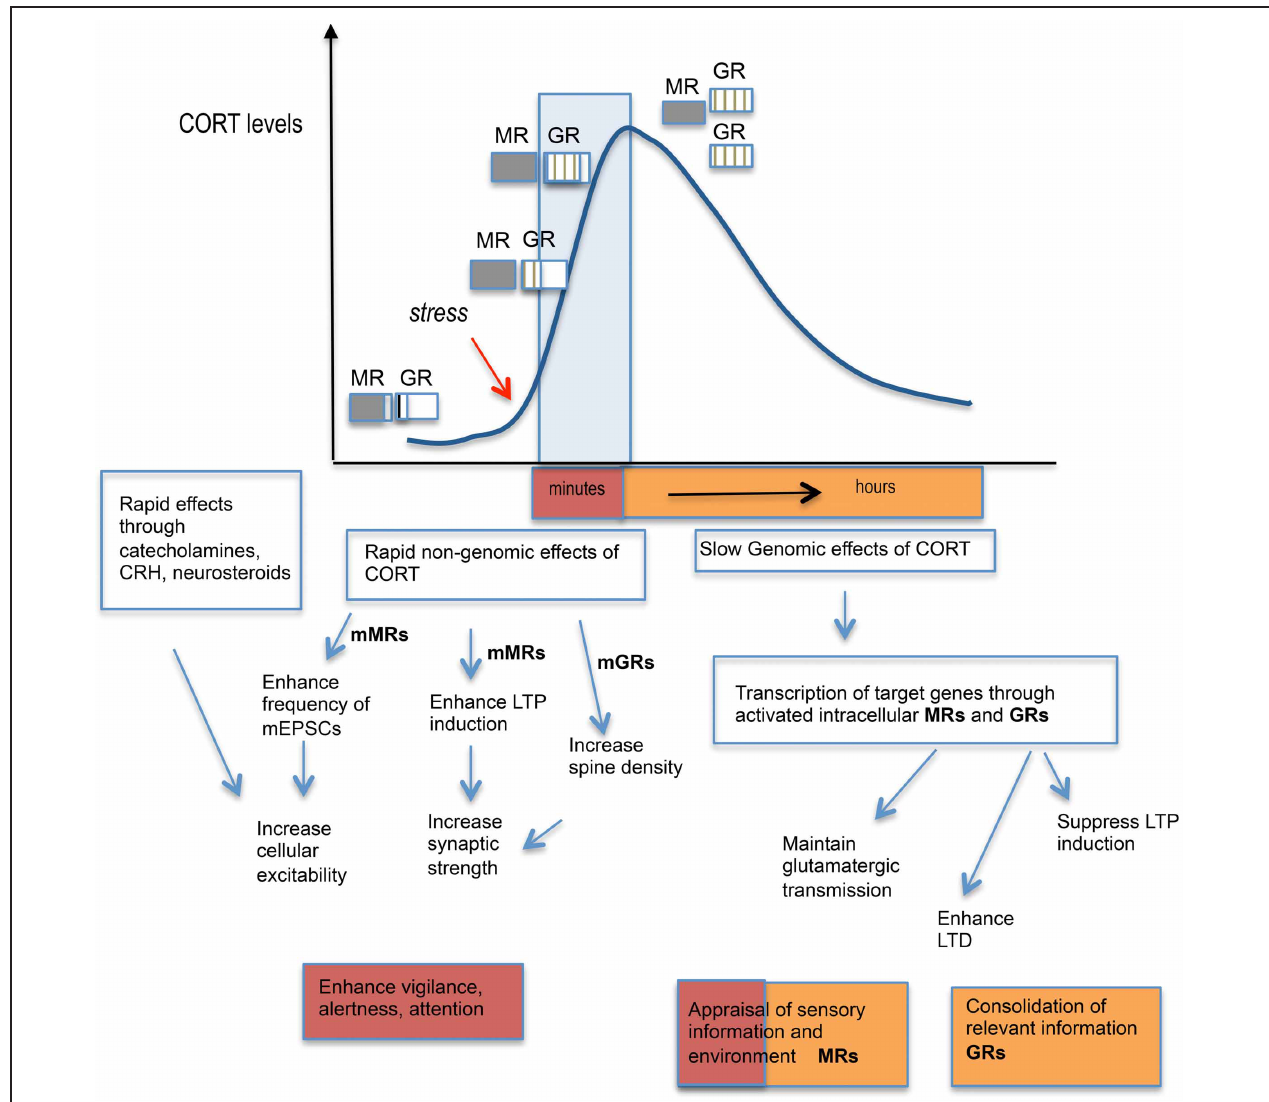
FIGURE 2 | Schematic diagram showing stress hormone effects: from cellular responses to behavior. Activation of the HPA axis by stress leads to a rapid rise in circulating corticosterone (CORT) levels which starts to fully occupy MR and increasingly occupy GRs. The varying level of occupancy of MRs and GRs are represented by extent of shading or lines within the boxes. The CORT levels normally return to baseline levels by 2h through negative feedback regulation upon the HPA axis. The initial rapid effects of CORT via activation of membrane-located MRs enhance LTP induction and enhance miniature excitatory postsynaptic currents in the hippocampus while membrane-located GRs appear to increase neuronal spine density. Together with other stress hormones released such as the